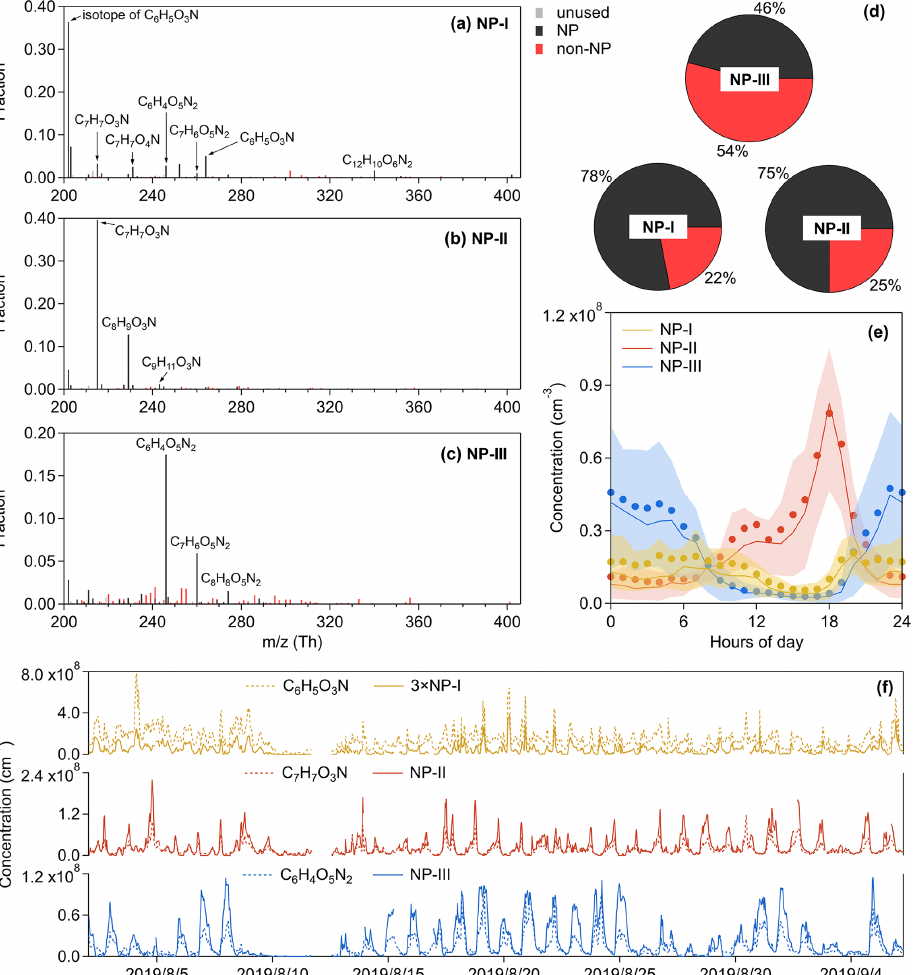
Figure 11. Mass spectra of (a) the NP-I factor, (b) the NP-II factor, and (c) the NP-III factor, and the elemental formulas of major peaks are labeled above them. The gray bars are fluorinated contaminations or non-identified compounds. The nitrated phenols are drawn separately with black peaks in (a–c) , while other OOMs are plotted as red peaks. The proportions of these two types of OOMs are shown in (d) the pie chart. The molecules represented by the gray were not included in (d) . Diurnal patterns of these three factors are shown in (e) : the bold solid lines are the median values; shaded areas represent percentiles of 75% and 25%; and solid circles represent mean values. (f) Time series of PMF factors and